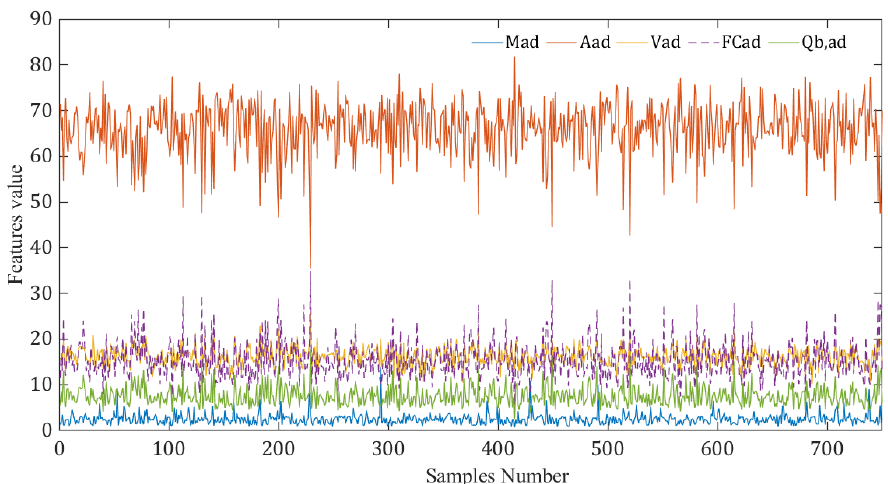
Figure 7. Data distributions of all features.